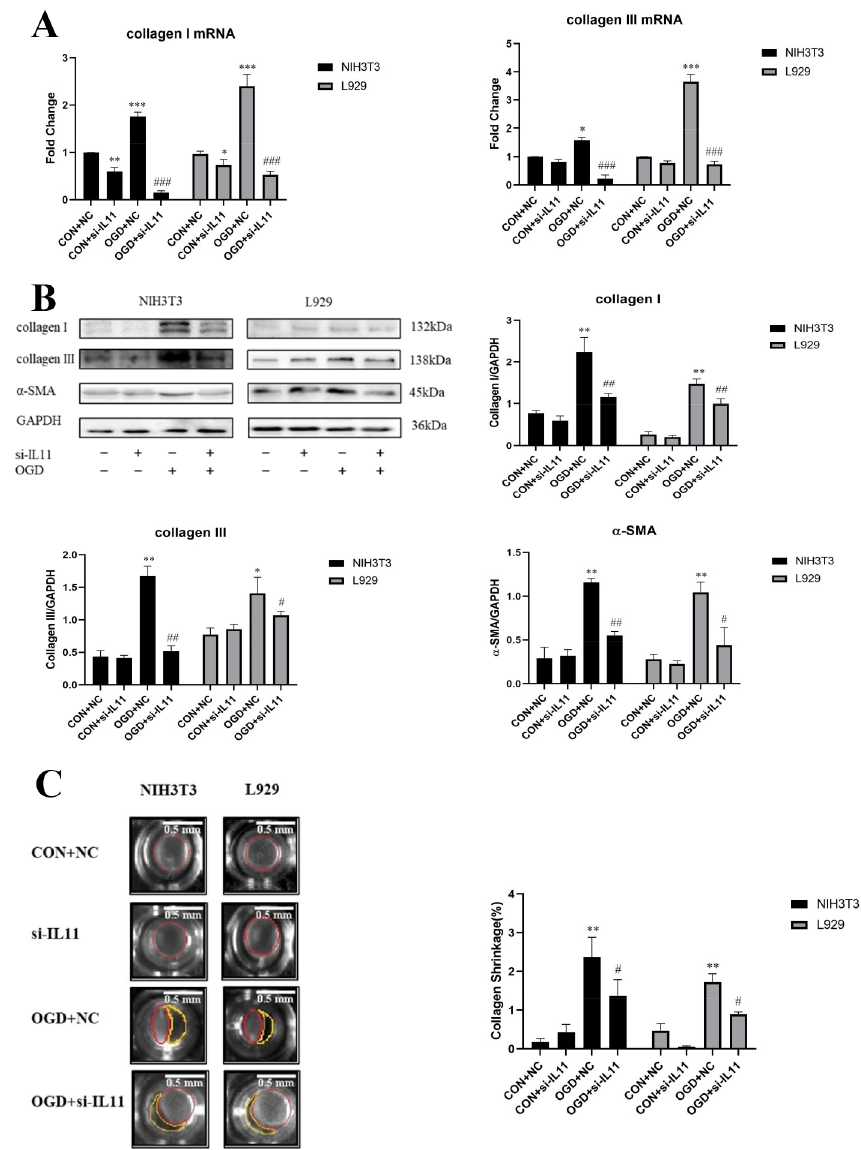
Figure 4. Interfering with IL11 inhibited fibroblast collagen expression. ( A ) mRNA expression was estimated by RT-PCR for collagen I and collagen III after inhibiting IL11 with siRNA after OGD- induced NIH3T3 and L929 cell senescence. ( B ) Western blot analysis and densitometric analysis of collagen I, collagen III, and α -SMA protein levels after inhibiting IL11 with siRNA in OGD- induced NIH3T3 and L929 cell senescence; GAPDH was used as the loading control. ( C ) Quantification of gel contraction and representative image of collagen gel containing OGD-induced senescent NIH3T3 and L929 cells with IL11 inhibited. OGD+NC—oxygen–glucose deprivation + negative control; CON+NC—control + negative control. The results are presented as the means ± SDs, and Student’s t -test was used to determine the p -value. * p < 0.05, ** p < 0.01, and *** p < 0.001, compared with CON+NC group; # p < 0.05, ## p < 0.01, and ### p < 0.001, compared with OGD+NC group.